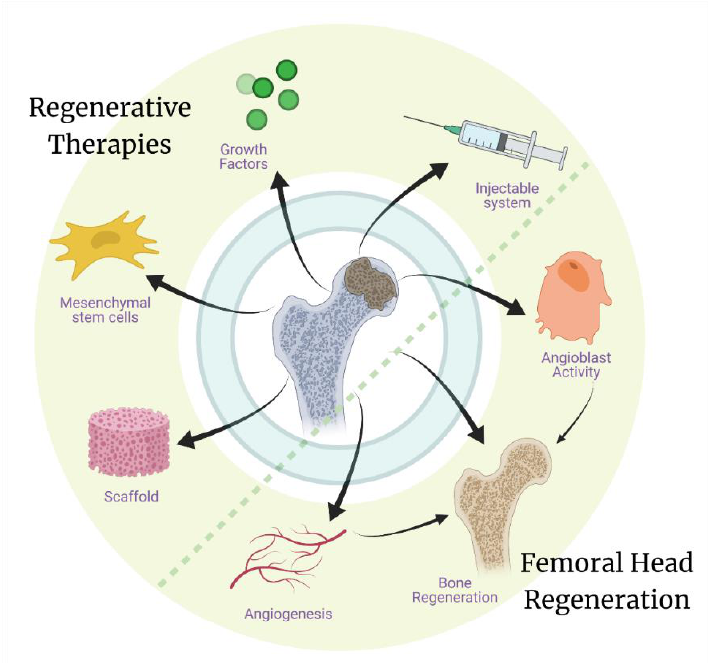
Figure 4. Regenerative therapies, including use of grafts/scaffolds with MSCs and growth factors, have shown promise in studies investigating the regeneration of the necrotic femoral head. While the development of a therapeutic system that can be delivered through a minimally invasive surgery will evade the surgical approach completely and can potentially help in both the regeneration of vasculature and the bone